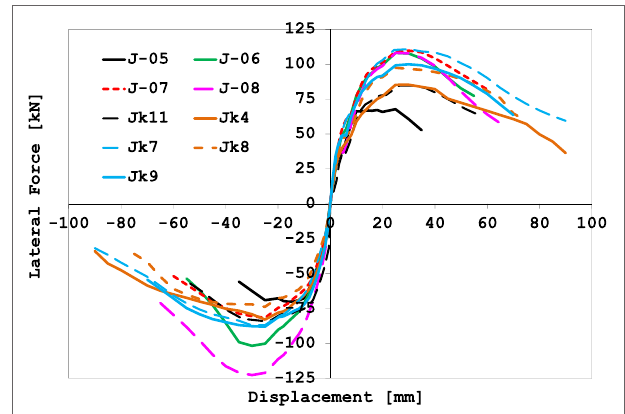
FIGURE 10 | Load-displacement envelopes: comparison between SRP and CFRP strengthened specimens.